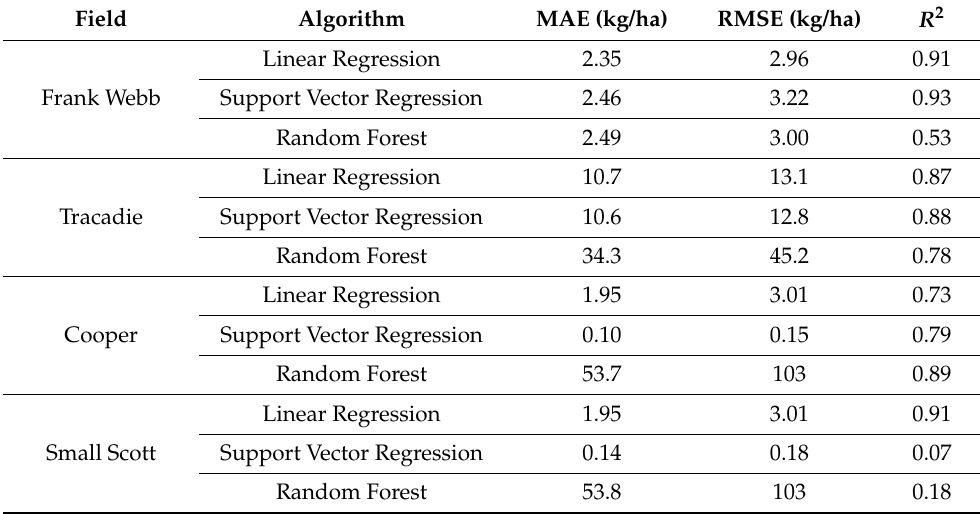
Table 4. Comparison of algorithms (linear regression, support vector regression, and random forest) within